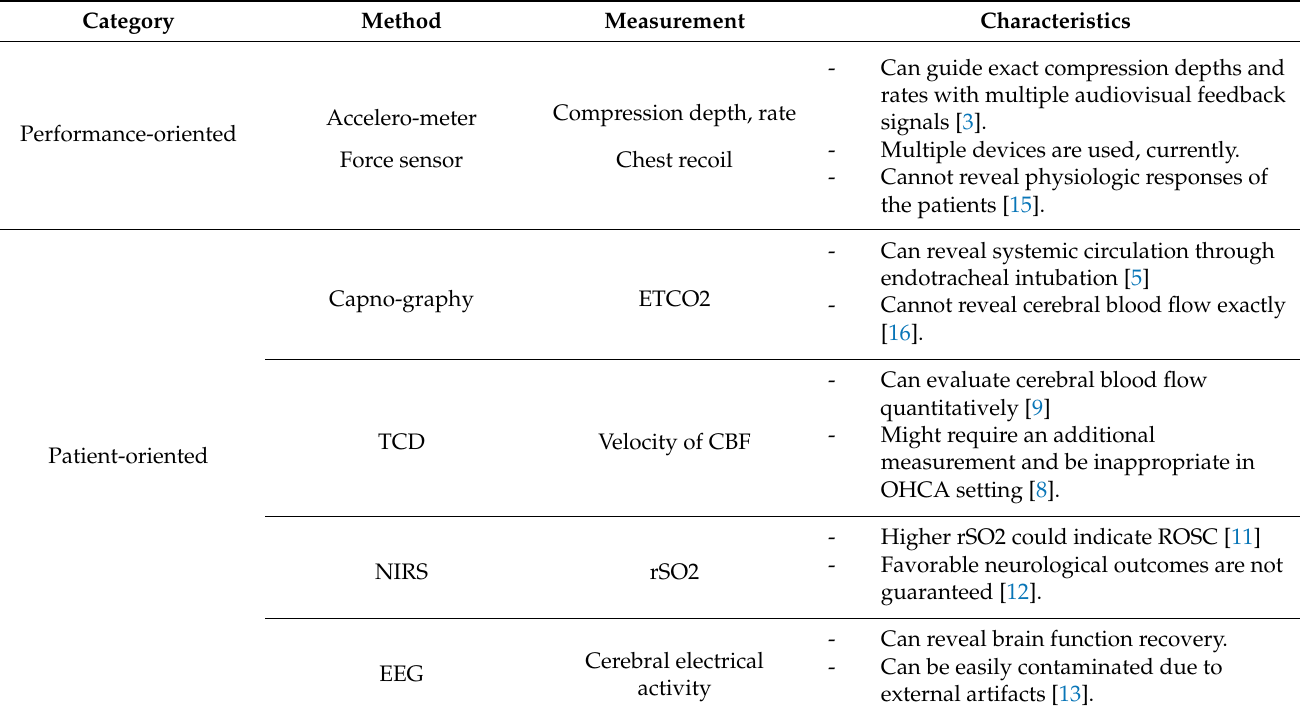
Table 1. Various state-of-the-art CPR feedback